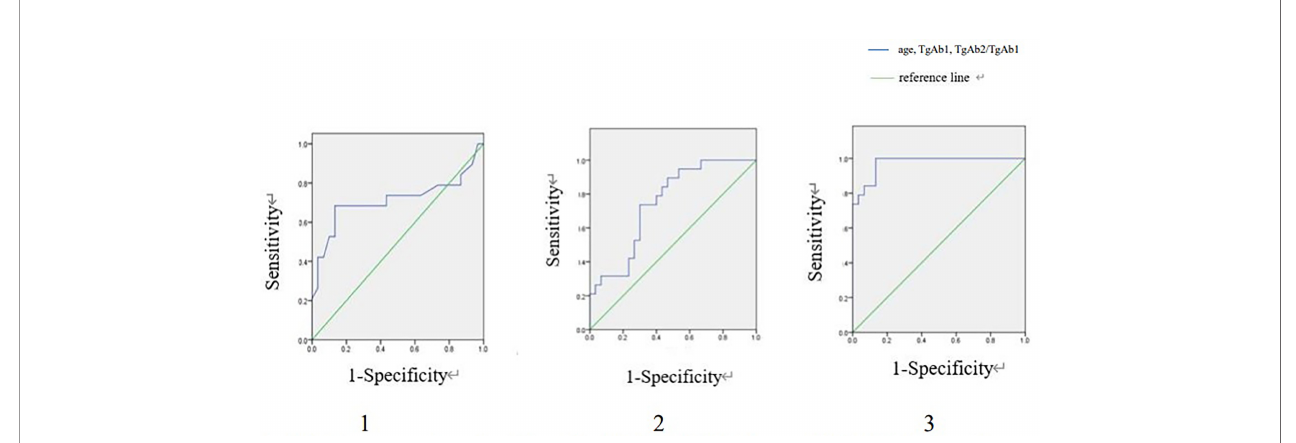
FIGURE 3 | ROC curves of age, TgAb1 and TgAb2/TgAb1 for detecting RAIR in TgAb positive group. ROC, Receiver operating characteristic; RAIR, radioactiveiodine refractory. 1. ROC curve of age for detecting RAIR in TgAb positive group. Area under the ROC curve (AUC) 0.712 (95% CI:0.539-0.885), cut-off value 55, sensitivity 0.684, speci fi city 0.867. 2. ROC curve of TgAb1 for detecting RAIR in TgAb positive group. AUC 0.747 (95% CI:0.612-0.883), cut-off value:297, sensitivity: 0.737, speci fi city 0.700. 3. ROC curve of TgAb2/TgAb1 for detecting RAIR in TgAb positive group. AUC 0.974 (95% CI:0.000-1.000), cut-off value 0.536, sensitivity 0.947, speci fi city 0.867.